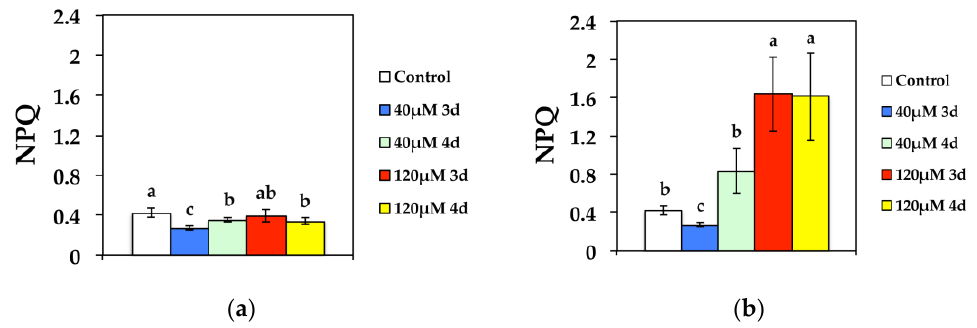
Figure 5. Changes in non-photochemical fluorescence quenching (NPQ) measured at ( a ) 300 μmol photons m −2 s −1 or ( b ) 1000 μmol photons m −2 s −1 . N. caerulescens plants were grown at 0 (control), 40 or 120 μ M Cd 2+ for 3 and 4 days.